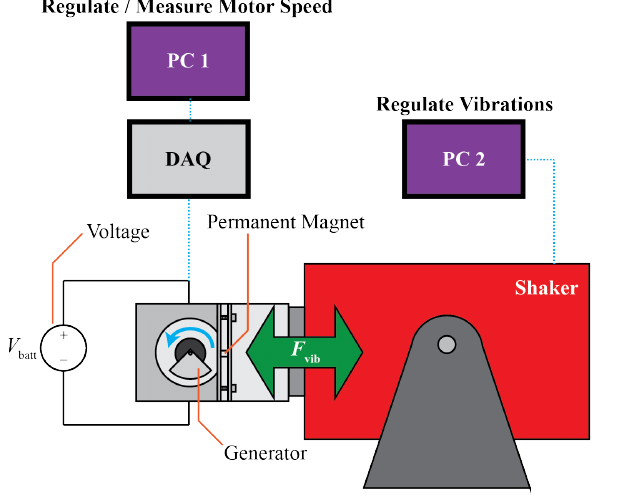
Figure 14. Setup of the measurement equipment.